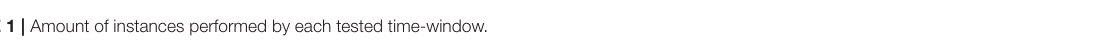
TABLE 1 | Amount of instances performed by each tested time-window.